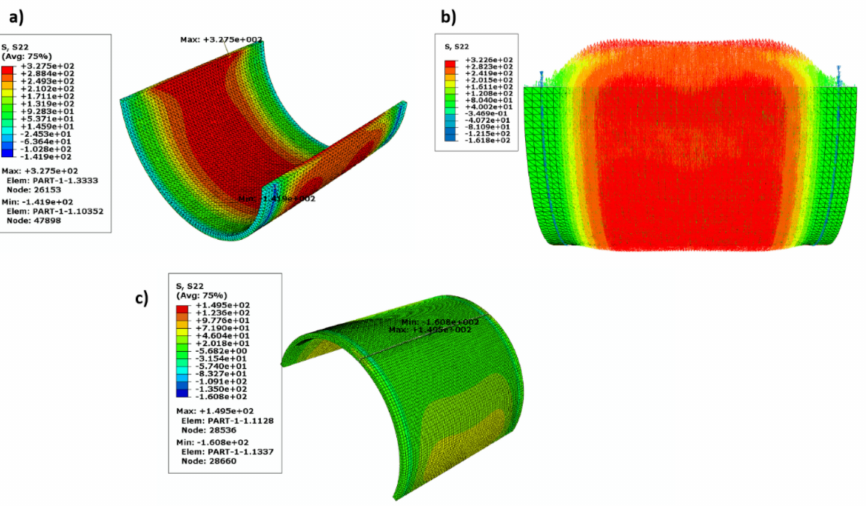
Figure 18. Hoop stress distribution ( a ) cylinder ( b ) cylinder with stress direction, ( c ) cracked cylin- der.